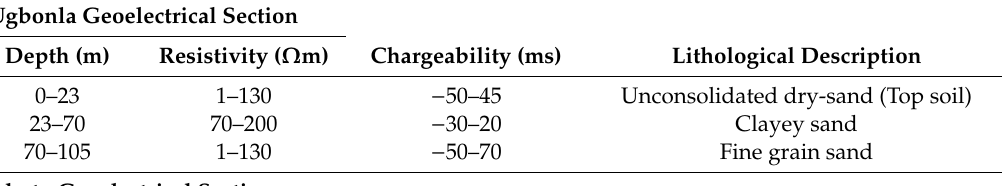
Table 4. Lithological interpretation of geoelectrical sections from Profile